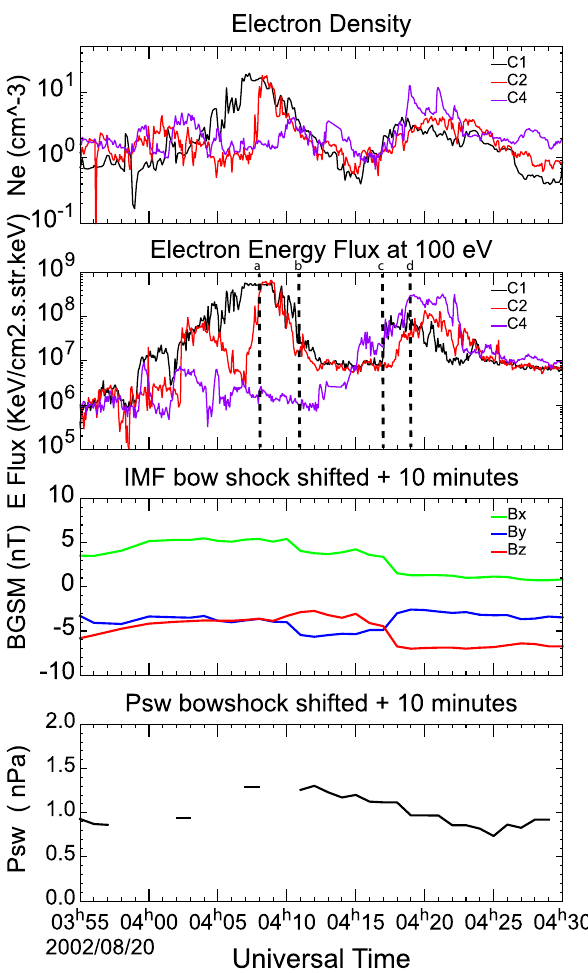
Fig. 5. Top: electron density measured by PEACE on C1 (black), C2 (red) and C4 (magenta). Second from top: electron energy flux for an energy around 100eV from C1, C2 and C4. Third from top: IMF in GSM. Bottom: solar wind dynamic pressure propagated to the bow shock with 10min additional delay for the propagation from the bow shock to the mid-altitude cusp.